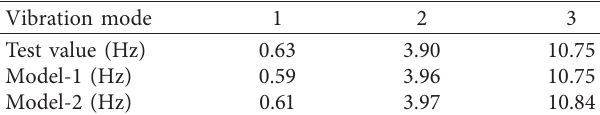
Figure 7: Vibration mode of the numerical simulation model. (a) Model-1, 1 st order vibration mode f � 0.59 Hz. (b) Model-1, 2 nd order Table 6: Comparison of natural vibration frequencies of models.